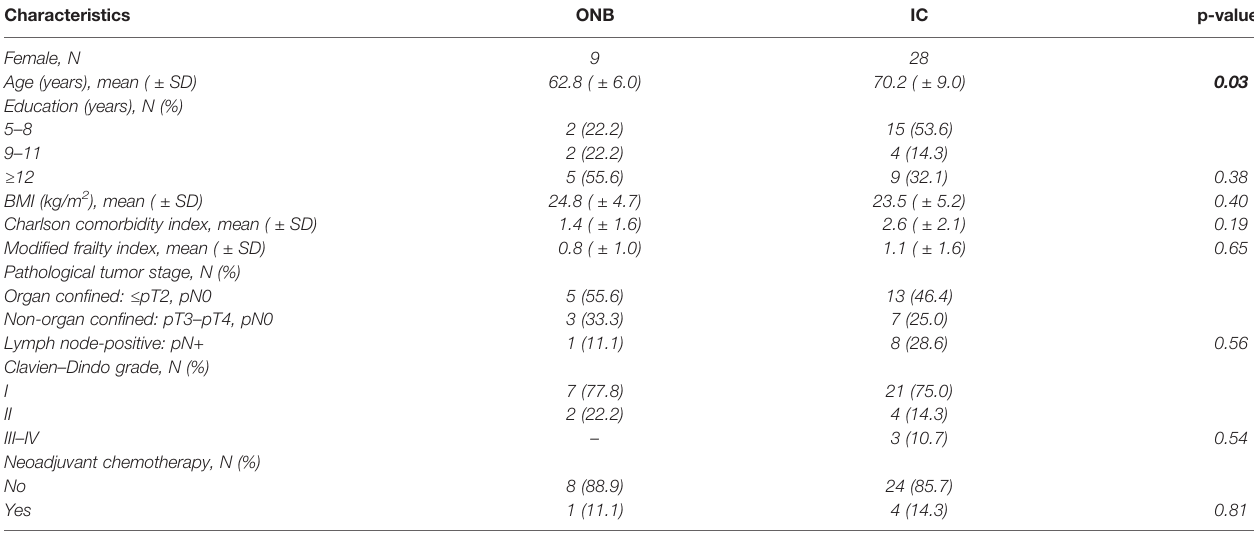
TABLE 1 | Demographic and pathological characteristics of female patients with RC for localized MIBC according to different urinary diversions: prospective multicenter study in Italy.